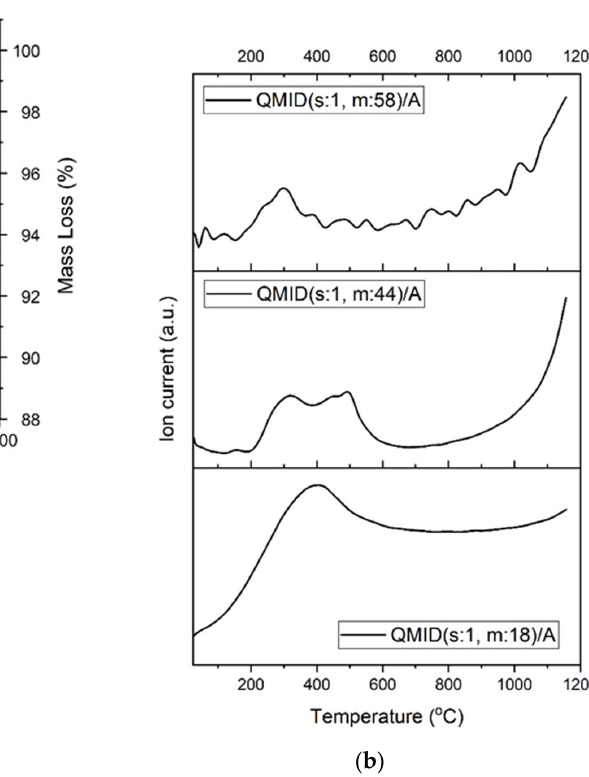
Figure 9. EGA results for petrol engine, where ( a ) presents DSC-TG signals, and ( b ) shows QMS registered signals. On the other hand, the examination of the filter from the Diesel engine shows similar behavior (Figure 10), but different gasses emitted were registered. From the room temper- ature up to approximately 600 °C, strong exothermic event on the DSC curve is visible, followed by less intense exothermic peek in the range from 600 to 700 °C. In this temper- ature range, the biggest weight loss of the sample was registered (~11 wt.%). This weight loss very likely is observed due to emission and decomposition of organic compounds collected on the filter. There is also some moisture contribution, as well (Table 2).